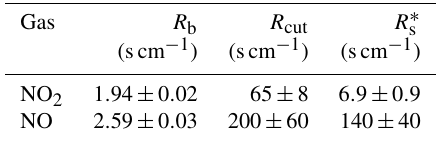
Table 3. Summary of deposition resistance parameters of Quercus agrifolia